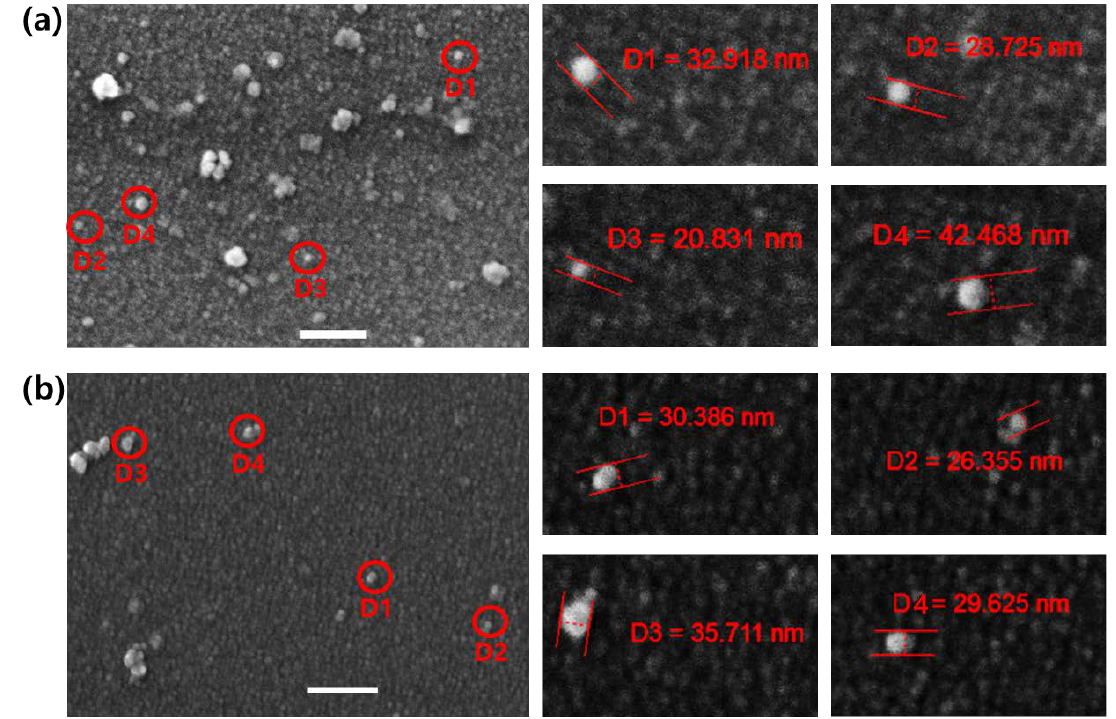
Figure 5. FE-SEM images showing the morphology of ( a ) JC-Fe 3 O 4 and ( b ) CT-Fe 3 O 4 NPs; Left: Single nanoparticles are marked with red circles. Right: Magnification of each single nanoparticle with the measured diameter (scale bar: 200 nm).